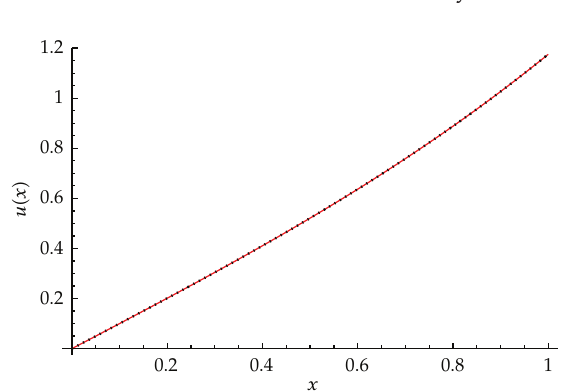
Figure 12: Solutions of (cid:4) 4.18 (cid:5) and (cid:4) 4.19 (cid:5) . Dotted line: the 5th-order approximate HAM solution at (cid:2) (cid:9) − 1 and solid line: the exact solution.